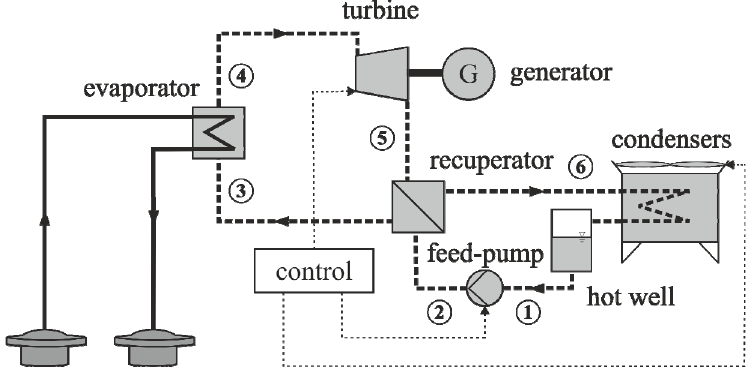
Figure 1. Diagram of a recuperative small, modular geothermal Organic Rankine Cycle (ORC) with adaptive